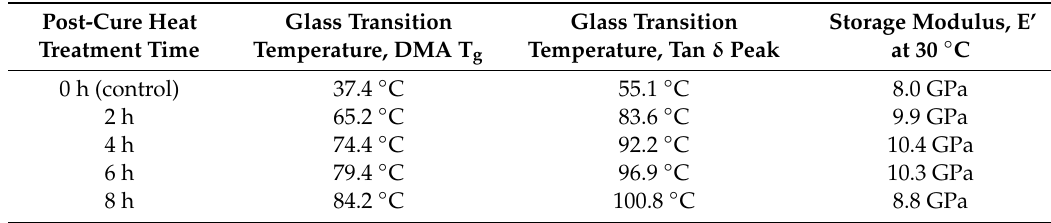
Table 2. Summary of composite glass transition temperature and storage modulus as functions of post-cure heat